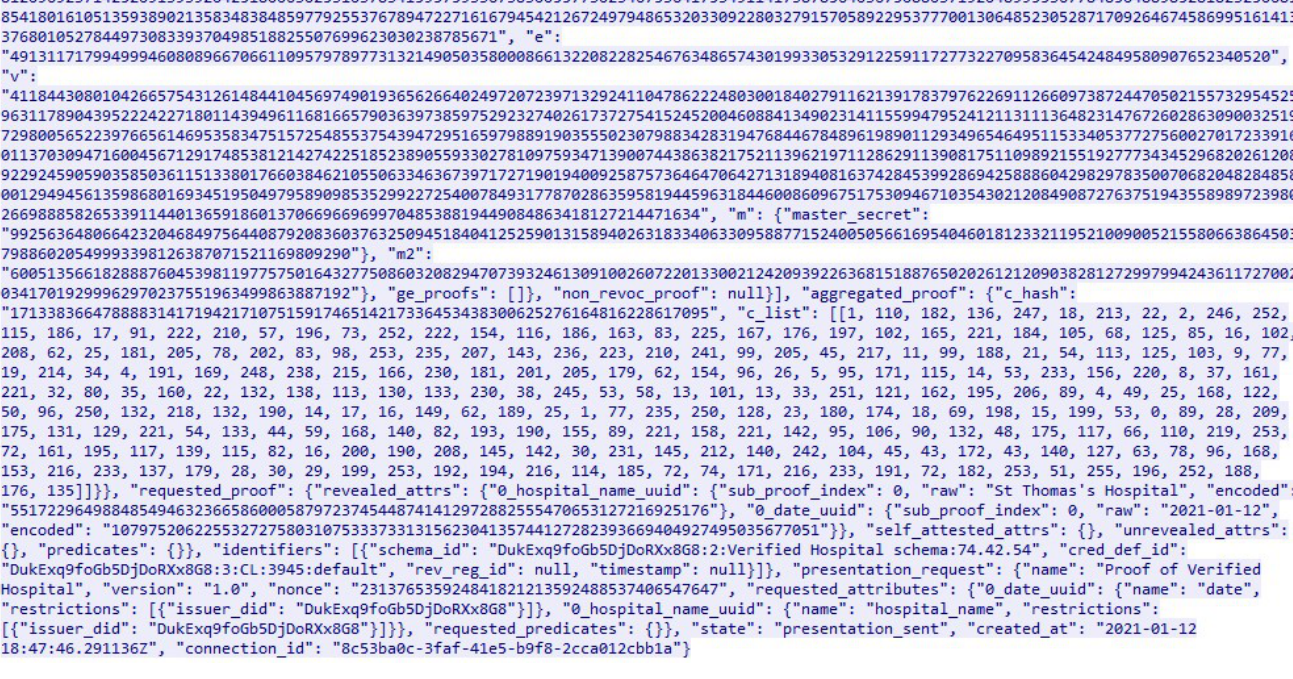
Figure A1. Communication between agent and controller is not encrypted during the connection